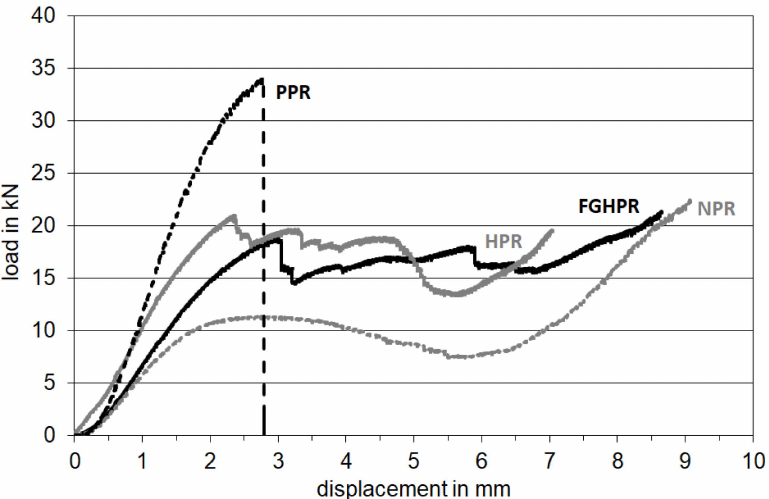
Figure 11. The load–displacement curves of the PPR, NPR, HPR and FGHPR lattice beam samples tested under four-point